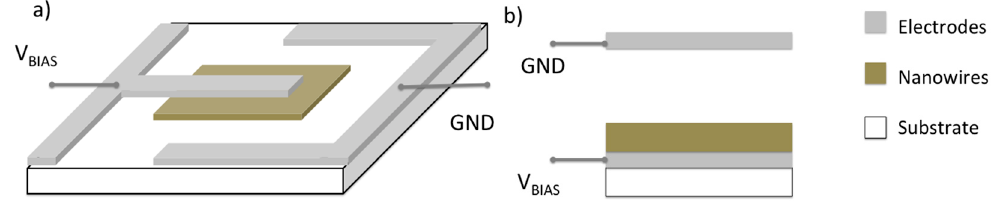
Figure 7. Schematic layout of the planar ( a ) and vertical ( b ) surface ionization device.